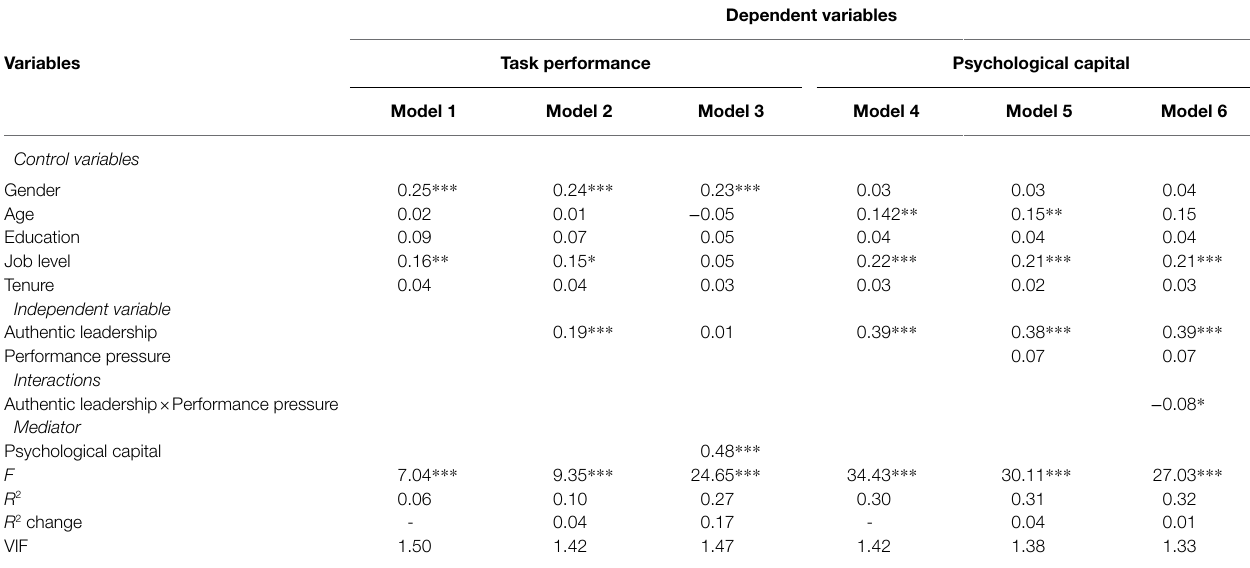
TABLE 3 | Results of the hierarchical multiple regression analysis of the study variable’s effects on task performance and psychological capital; standardized coefficients ( n = 485).